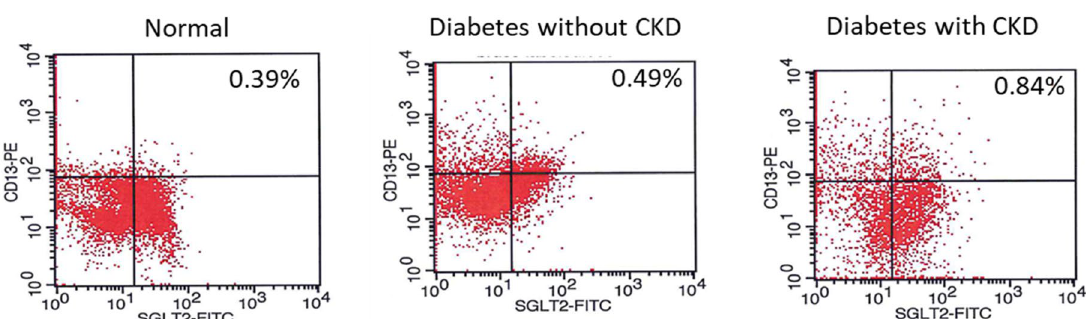
Figure 4. Flow cytometry showing that renal proximal tubule cells are present in the urine in normal subjects and diabetic patients with and without CKD. Human proximal tubule cells are in the right upper quadrant (positive for SLGT2 and CD13). The percentage of proximal tubule cells within total urinary exfoliated cells are shown, n =